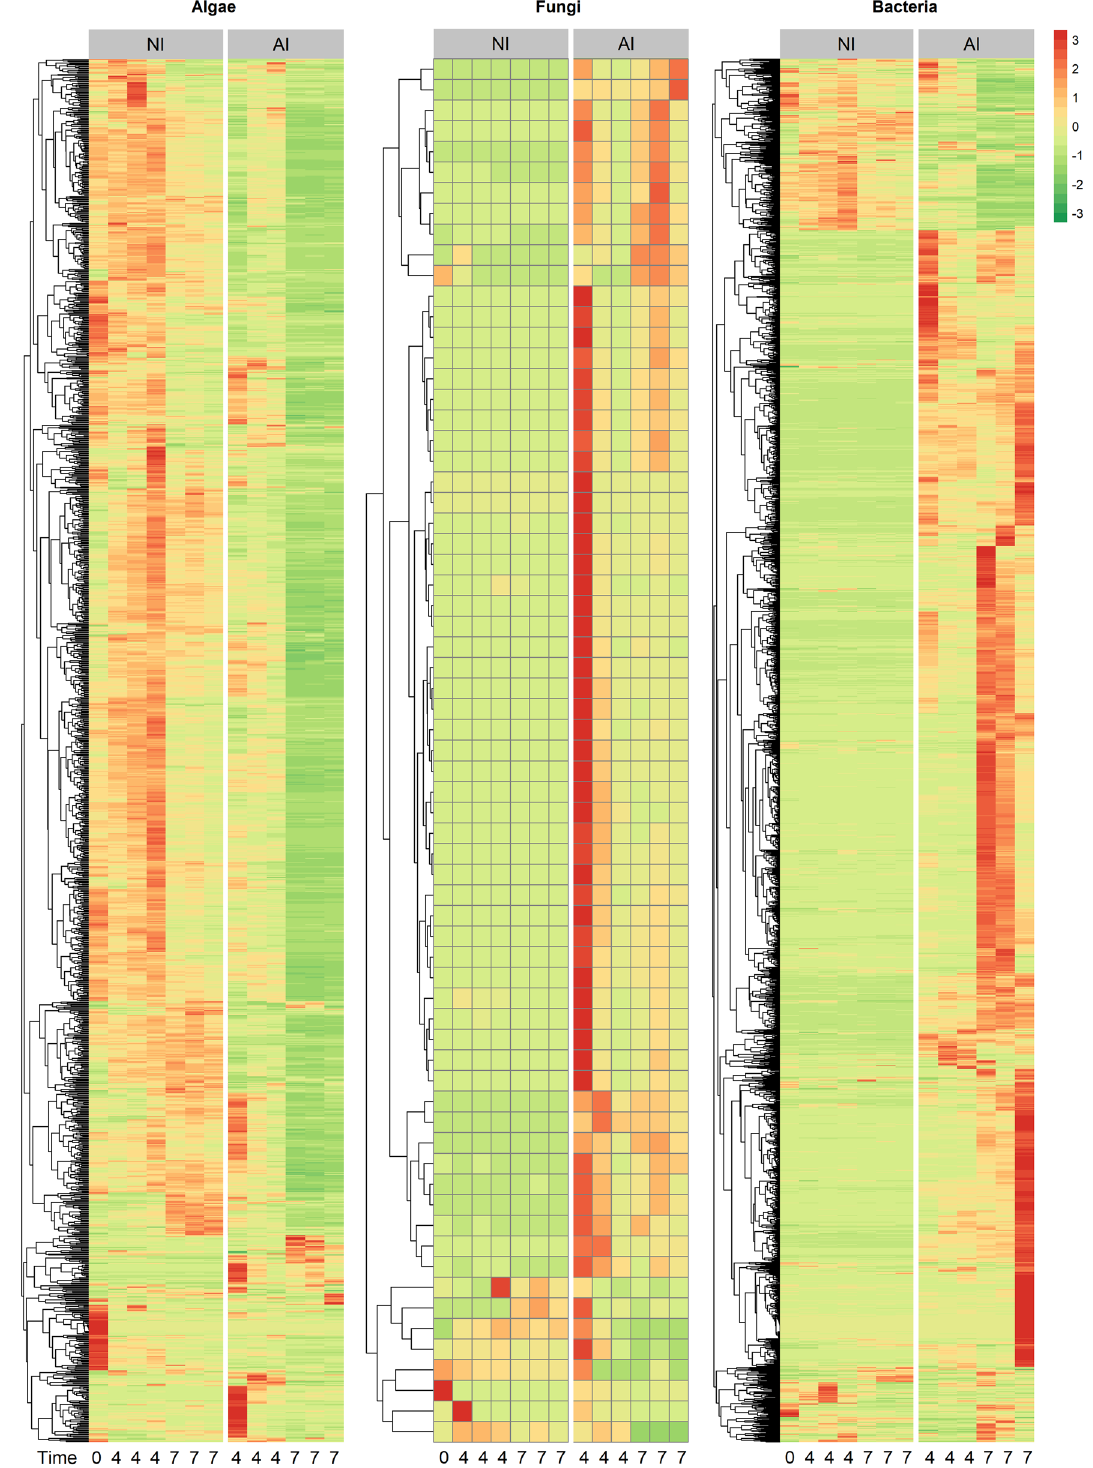
Figure 3. Mean of relative abundances of algal, fungal and bacterial protein groups (PGs) over time. Red colors indicate higher, while green colors indicate lower protein abundances of aphelid-infected (AI) and non-infected (NI) S. vauolatus cultures 0, 4 and 7 days post inoculation (DPI). The hetamp was calculuated in the open- source platform R (v3.6.1) with the pheatmap package v1.0.12 (RRID: SCR_016418) 55 .The tree based on PG presence represents the clustering of euclidean PG